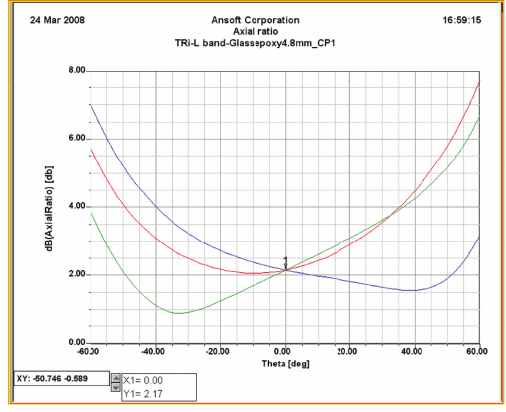
Figure 6: Axial ratio.